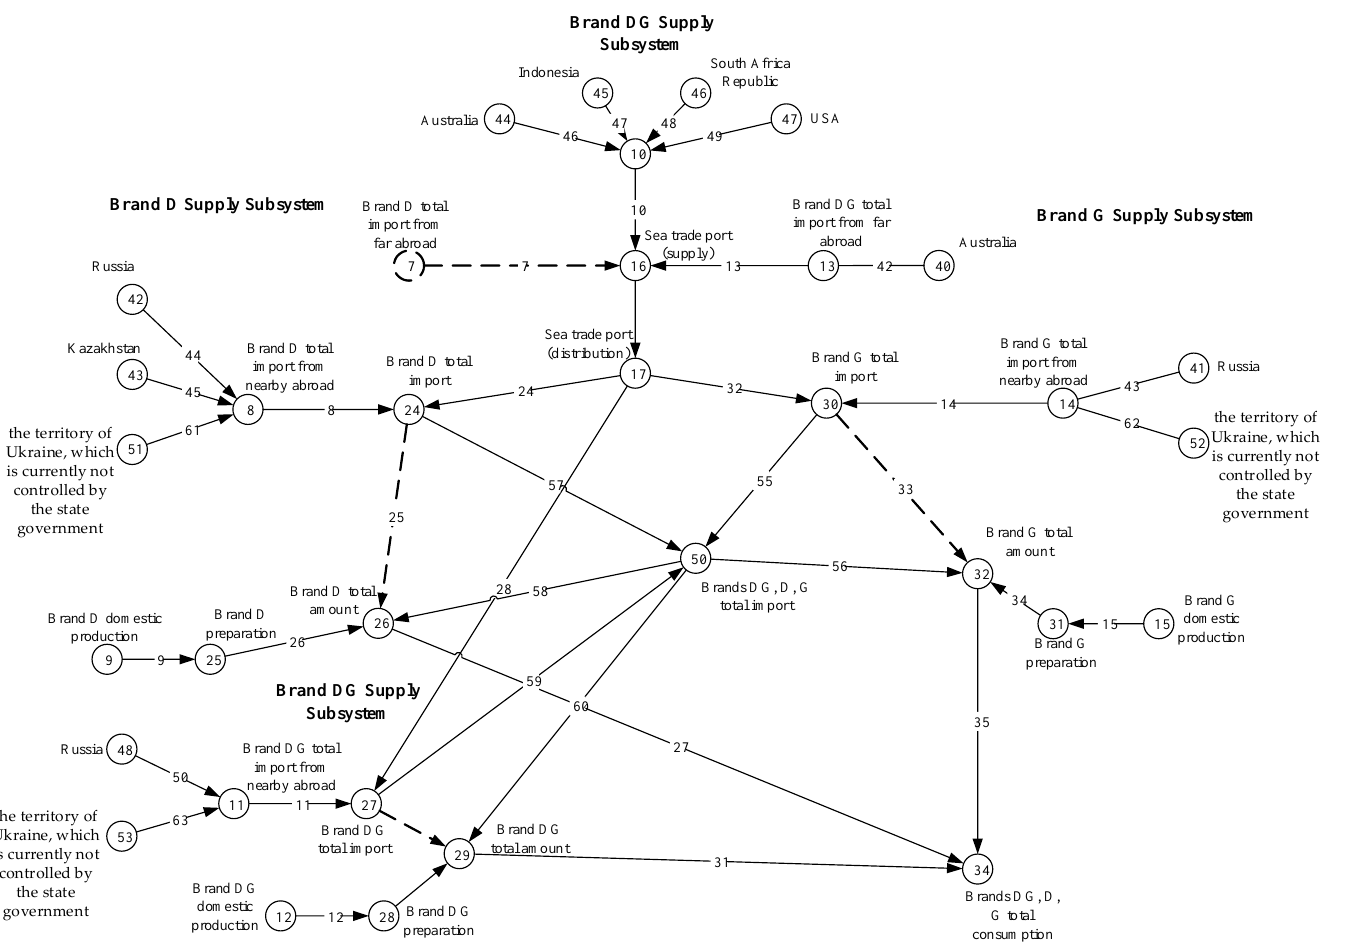
Figure 4. High volatile coal supply subsystem [82] (p. 100). The application of this model to the Ukrainian coal sector implies that only some part of mines can be reconstructed or modernized at the coal mining enterprises located on the controlled territory of the country [83 – 85]. Other enterprises have practically exhausted reserves, and the implementation of high-cost modernization measures is considered unreasonable for them. Reconstruction of enterprises that are privately owned is beyond the scope of this work considering that the state does not have a significant influence on the owners for investing in their development.